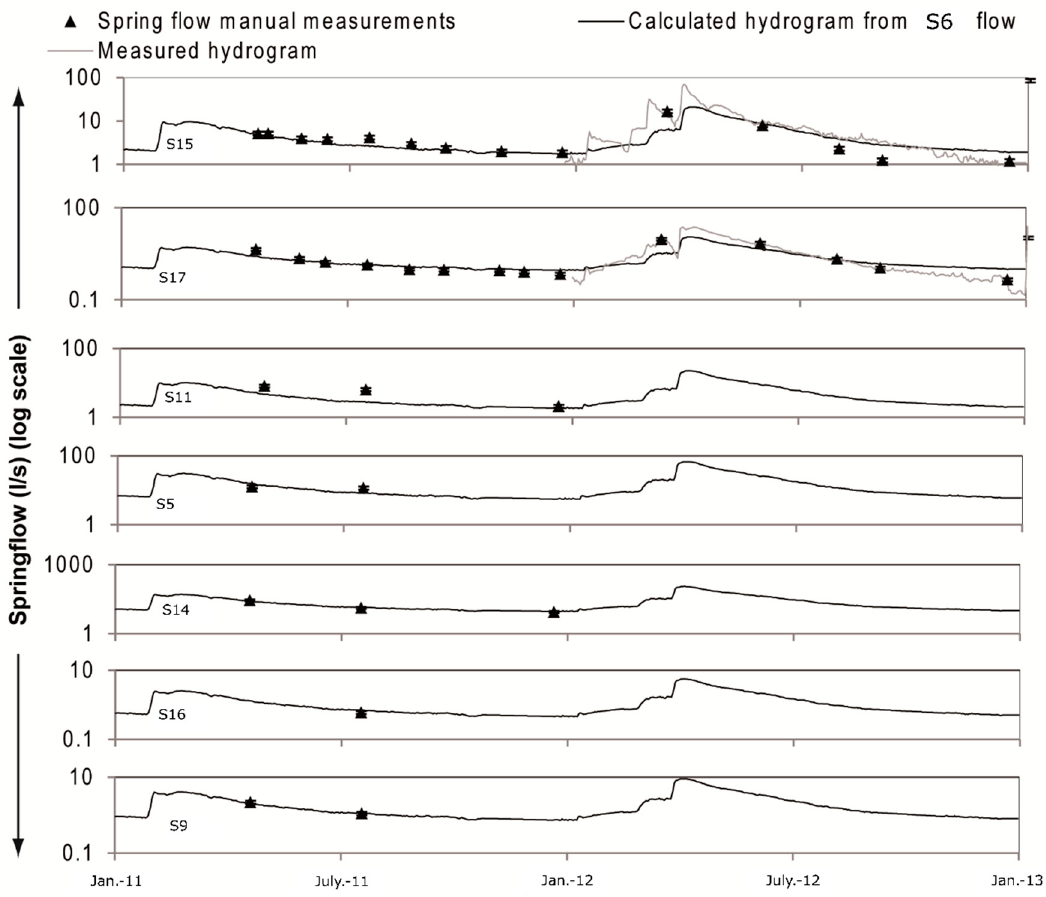
Figure 7. Comparison of spring-flow measurements (continuous and one-off measurements) with hydrographs reconstituted from recorded flow at the Clain (S6) spring. Springs with flow measurements only from helicopter surveys are not shown.